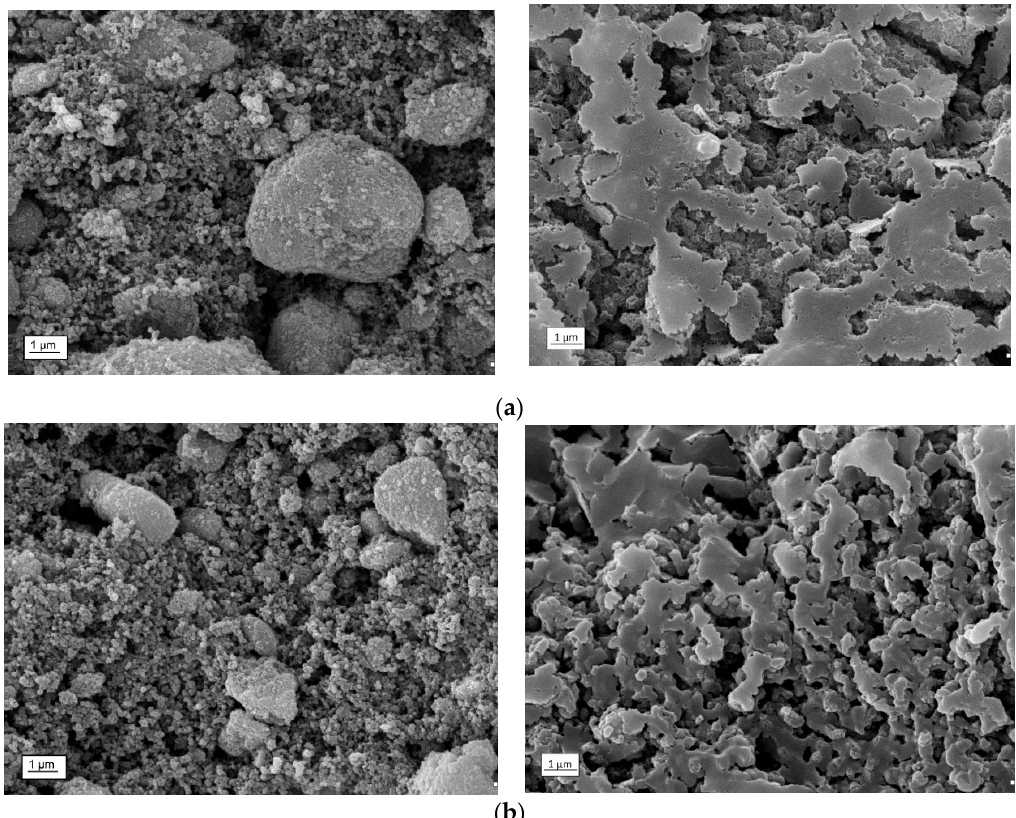
Figure9. SEMimagesofobtainedmaterials: ( a )S 2 V 0 Ti 1 ; ( b )S 2 V 1 Ti 1 . ( left )Beforecharging / discharging; ( right ) After charging /